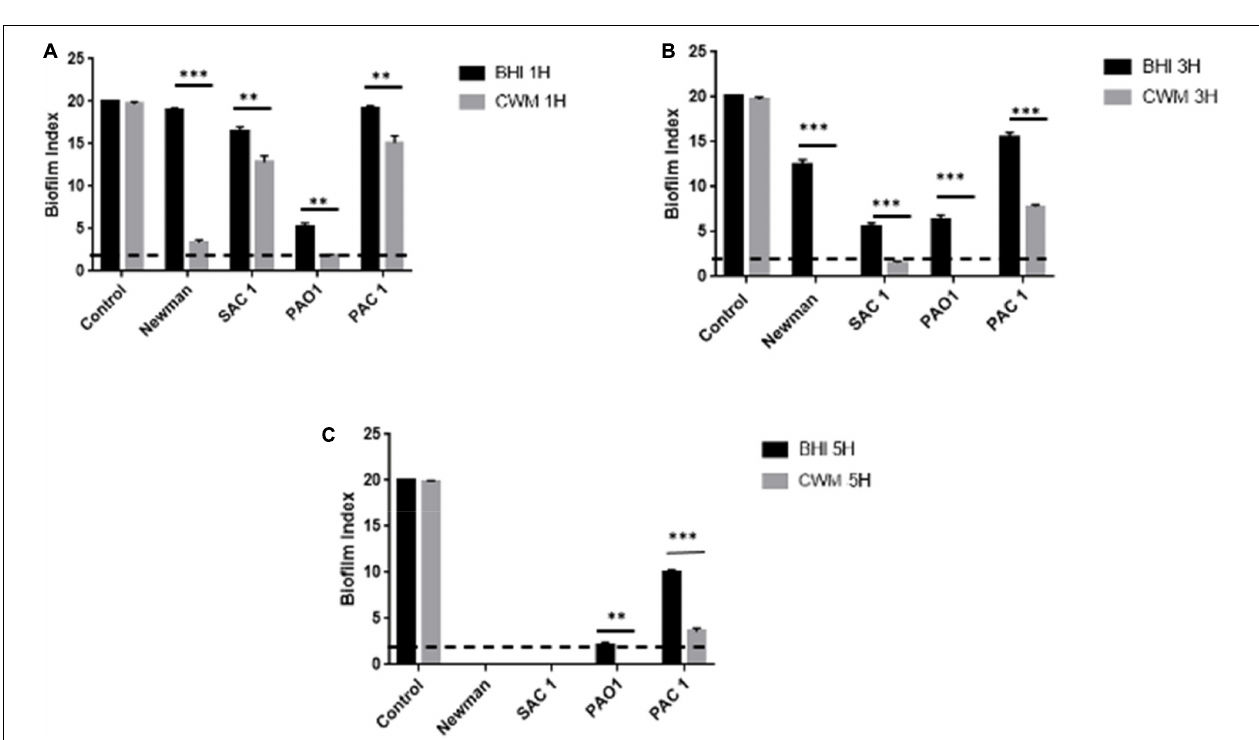
FIGURE 2 | Growth curves of 1:1 coreference clinical (A) and clinical (B) strains of S. aureus and P. aeruginosa in CMW and BHI media. Cultures were sampled at the indicated time points, and the numbers of bacteria were estimated by CFU enumeration of P. aeruginosa and S. aureus on selective medium. Experiments were performed in three biological replicates; data points represent the average of these replicates, and error bars represent the standard deviation. Comparisons were performed with t -test. Significance was set to a p < 5%. ns, not significant; ∗ p < 0.1.